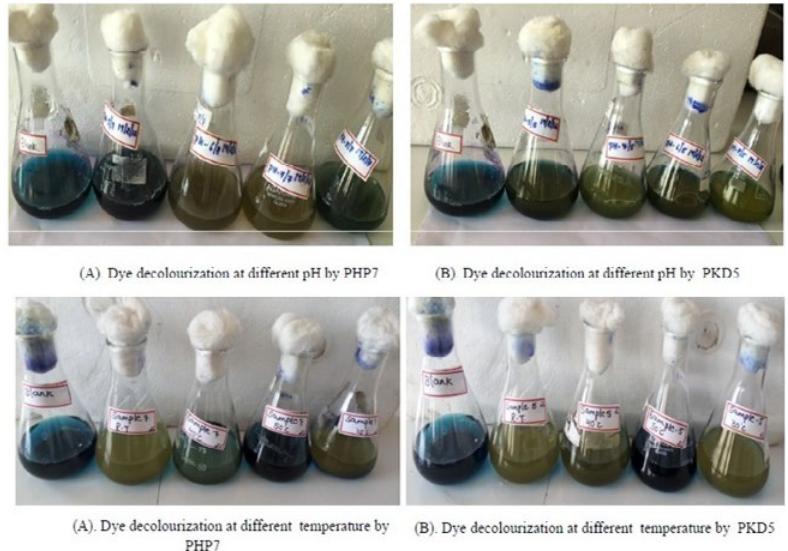
Fig. 4: Dye decolourization at different pH and Temperature by PKD5 and PHP7 isolates Fig. 4. Dye decolourization at different pH and Temperature by PKD5 and PHP7 isolates Table 7: Dye degradation of PHP7 and PKD5 at different temperature Table 7. Dye degradation of PHP7 and PKD5 at different temperature OD at 450nm dye degradationPHP7 OD at 450nm dye degradationPKD5 Sr. No.